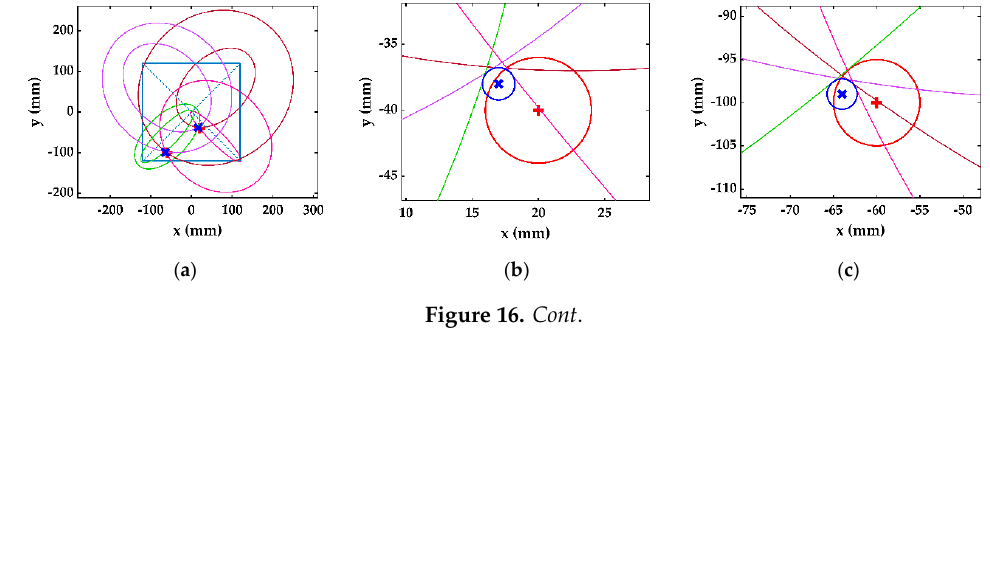
Figure 15. ( a ) Signal received at P2 in plate with multiple damages. ( b ) CWT of ( a ).